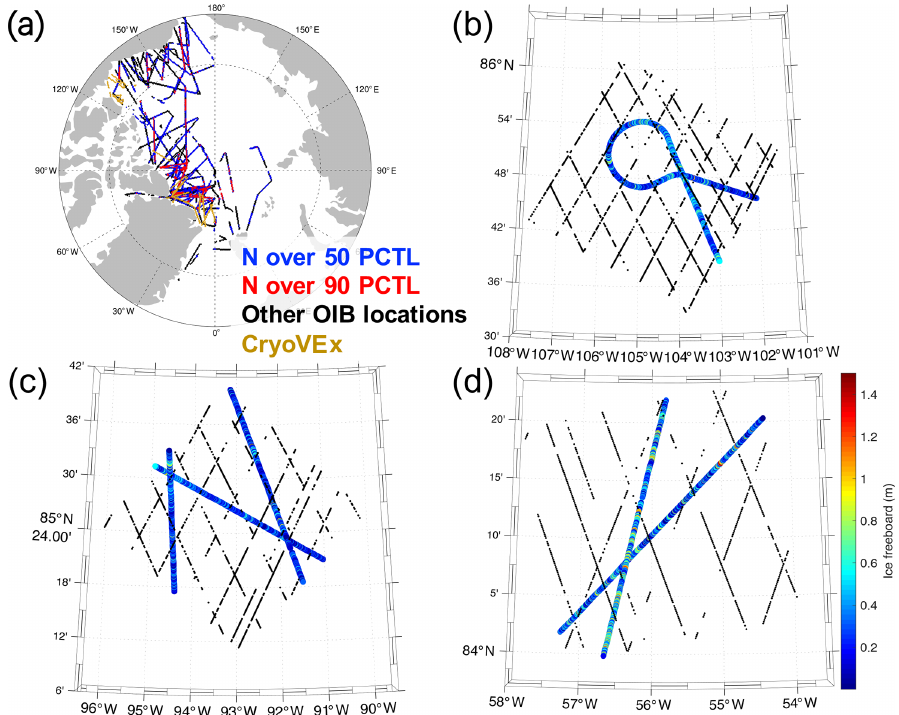
Figure 2. Locations of OIB and CryoVEx measurements from 2011 to 2017 (a) , with sample regions of good OIB coverage (b–d) . Local OIB sample counts (N) over the 50th and 90th percentiles (PCTL) are shown in different colors in (a) . OIB-measured ice freeboard values are shown in color in (b–d) , with effective ESA CS-2 samples within the same month of the OIB campaign shown with black dots.